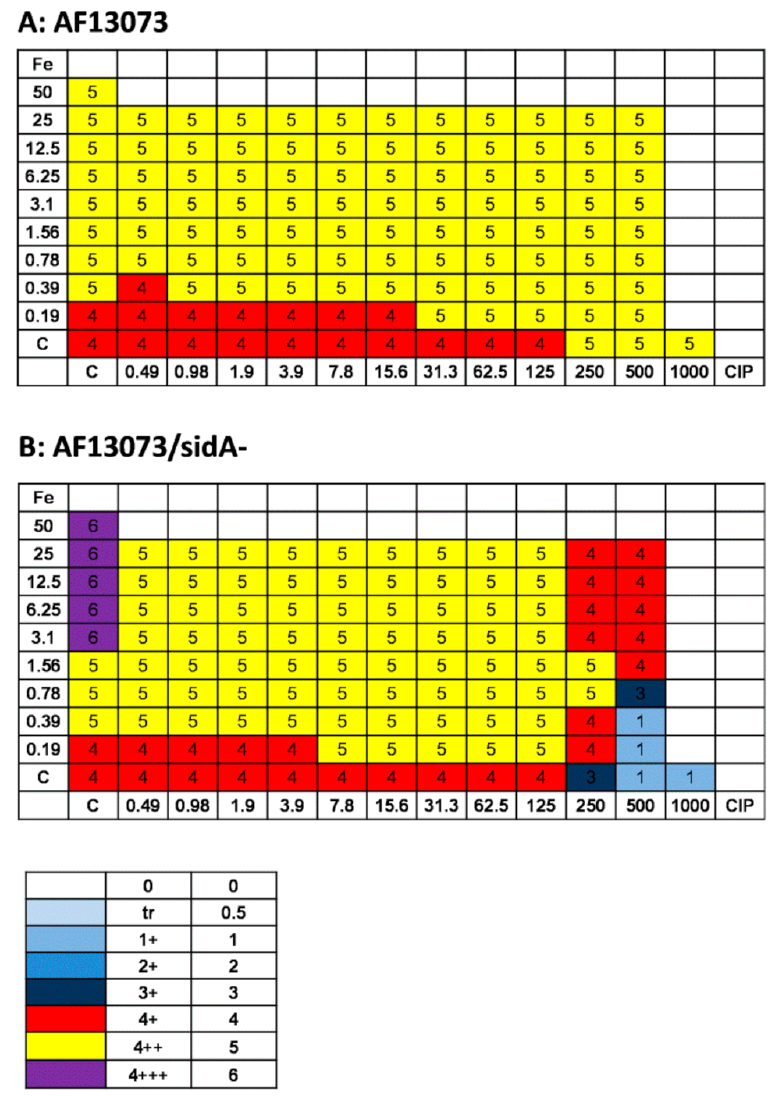
Figure 6. Iron does not further increase the profungal effects of CIP on the planktonic growth of A. fumigatus . CIP (final concentrations 0.49–1000 µ g/mL in RPMI 1640 medium) was combined with FeCl 3 (iron; final concentration 0.19–12.5 µ M in RPMI 1640 medium) using ( A ) AF13073 or ( B ) AF13073/ sidA - conidia, according to CSLI guidelines for macro-dilution. The tubes were incu- bated at 37 ◦ C for 48 h. Fungal growth was measured visually, and rated as described in the Material and Methods section, with the growth in control tubes being assigned a ‘4’, as per CLSI methodology. The tubes with less growth were rated a number between 0 and 3, and for the tubes with more growth than the control, a number 5 or 6, proportional to the amounts of growth. The color chart visualizes groups of iron/CIP combinations with the same growth. A: n = 2; B: n =